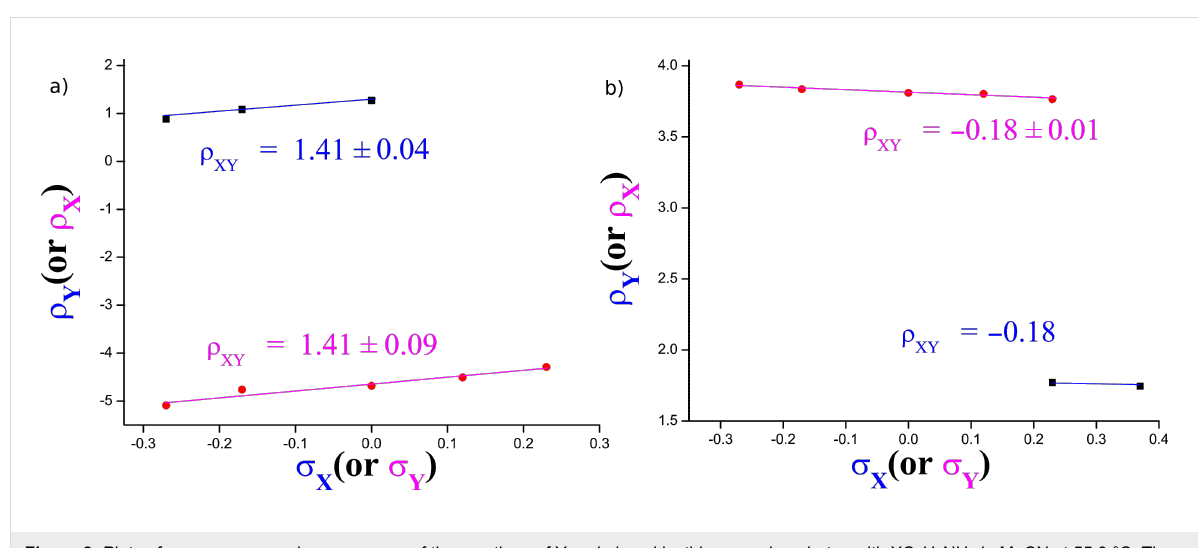
Figure 2: Plots of ρ X versus σ Y and ρ Y versus σ X of the reactions of Y-aryl phenyl isothiocyanophosphates with XC 6 H 4 NH 2 in MeCN at 55.0 °C. The obtained ρ XY values by multiple regression are as follows: (a) ρ XY = 1.40 ± 0.06 ( r = 0.992) with more basic anilines and (b) ρ XY = –0.18 ± 0.09 ( r = 0.975) with less basic anilines.